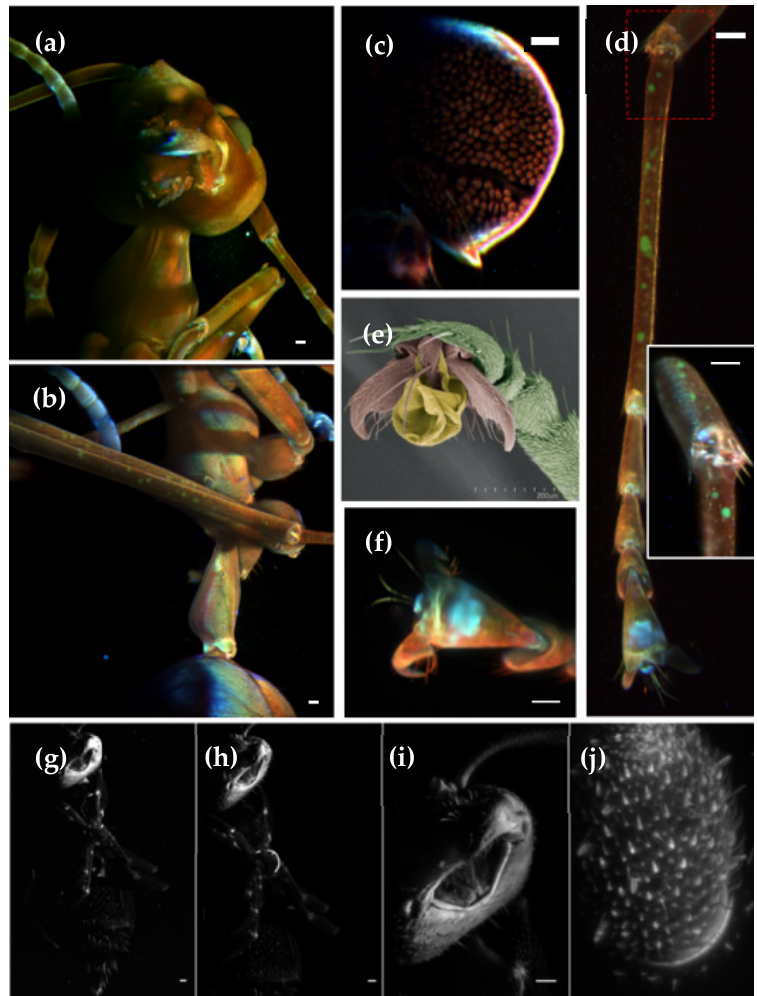
Figure 5. Maximum intensity projection of the auto-fluorescence from two different ant species. For Oecophylla smaragdina we imaged the ( a ) head and ( b ) the mid-body areas, using a 4× objective. Color images were obtained from three laser line illuminations: 488 nm (red), 568 nm (green) and 647 nm (blue). 3D volume renderings can be found in Video S5. ( c ) Single slice of the inner structure of the ant’s brain. ( d ) Ant leg imaged with higher resolution through a 16x objective, with the inset showing a zoom into the articulation region. ( e ) SEM image of an Oecophylla smaragdina claw. ( f ) Maximum intensity projection of a claw imaged using a 16× objective. Unidentified ant imaged with different objective magnifications ( g ) 4×, ( h ) 10×, ( i ) 16× and ( j ) 60×. In all cases we used a 488 nm laser illumination. Scale bar: 100 μ m.